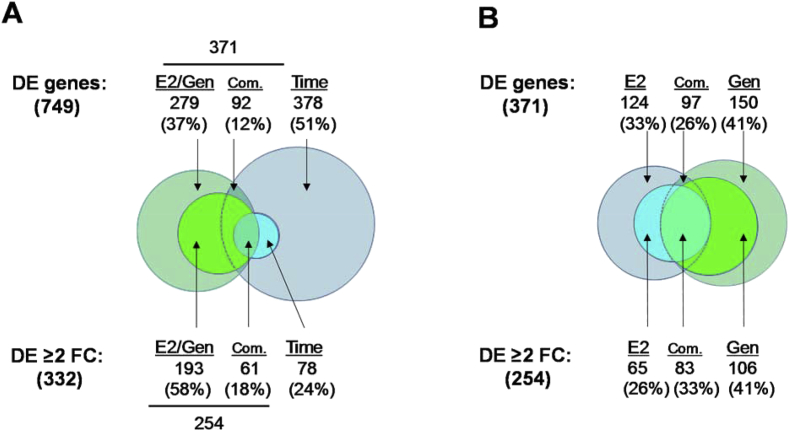
Proportion of differentially expressed (DE) genes identified in the present study. A. Venn diagrams representing common (Com.) and specific genes differentially expressed in sea bass scales in response to the treatments (17β-estradiol, E2, and/or genistein, Gen, compared to the corresponding controls at each sampling time 1 day and 5 days), compared to the differential expression in the control groups over time. The number of genes by treatment or time and their respective percentage are shown for two levels of stringency. “DE genes” above the diagram corresponds to the 749 genes differentially expressed at an FDR <0.05. Below the diagram the DE genes (332) differentially expressed with a minimum of 2-fold change are considered (“DE ≥ 2 FC” and FDR < 0.05). 51% of the “DE genes” changed expression only in control scales over time but these changes were of low magnitude (average fold change of 1.9-fold between C1d and C5d) and when the analysis stringency was increased to a minimum of 2-fold change, only 24% of these 332 genes changed expression in the control scales over time. The 254 genes (76%) significantly regulated by E2 or Gen were selected for further analyses. B. Shows the comparison of common/specific DE genes between E2 and Gen at the two stringency levels, FDR <0.05 or ≥2 FC and FDR <0.05 (irrespective of the sampling times). For the number of genes regulated by E2 and/or Gen at each sampling time see Fig. 2B of the associated paper in JSBMB [1].